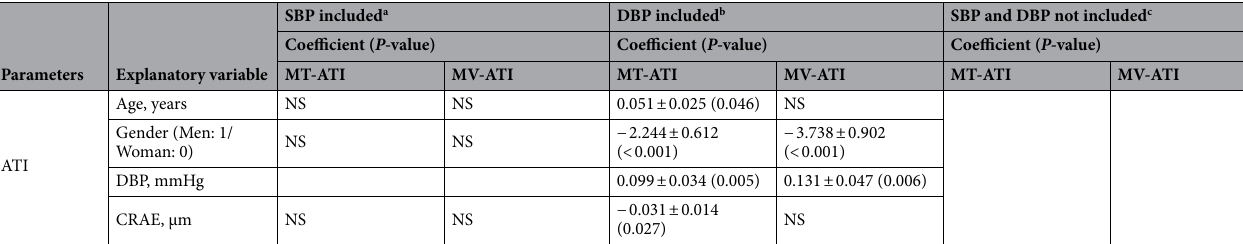
Table 4. Results of the multivariate linear mixed effect model analysis evaluating the contributing factors to pulse waveforms of MT and MV. The values indicate estimated partial correlation coefficients ± standard error and those in parentheses indicate P values. ATI acceleration time index, AU arbitrary unit, BOS blowout score, BOT blowout time, CRAE central retinal artery equivalent, DBP diastolic blood pressure, FAI flow acceleration index, FR falling rate, HR heart rate, MT mean blur rate (MBR) in tissue area, MV MBR in vessel area, PPA peripapillary atrophy, RR rising rate, SBP systolic blood pressure, NS not significant. a Only SBP was adopted as an explanatory variable since univariate analysis yielded a P value less than 0.2 for both SBP and DBP. b